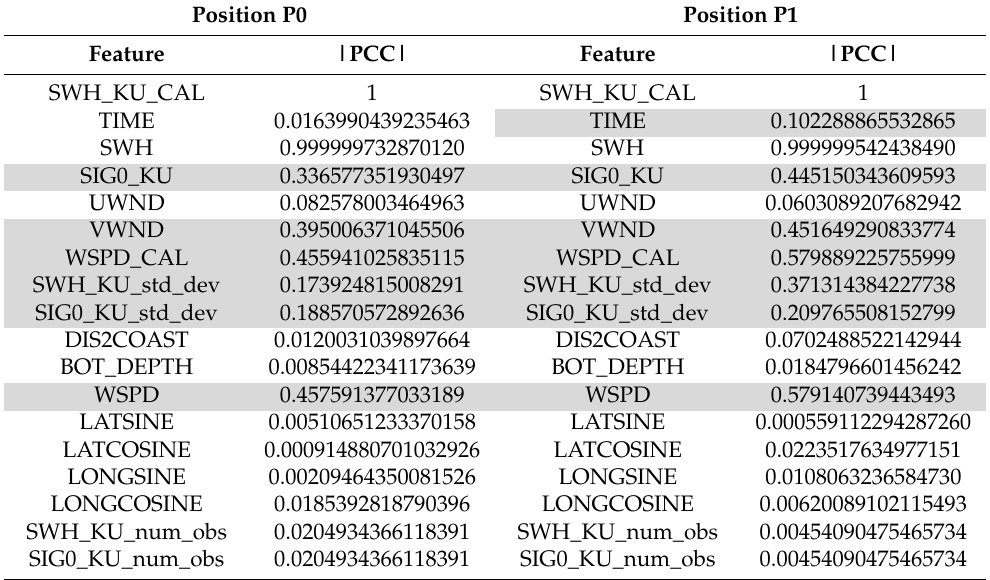
Table 5. Absolute values of Pearson correlation coefficients between SWH_KU_CAL and the KU- based features for positions P0 and P1; The features included in the PCC-Set and their correlation values are highlighted in gray.